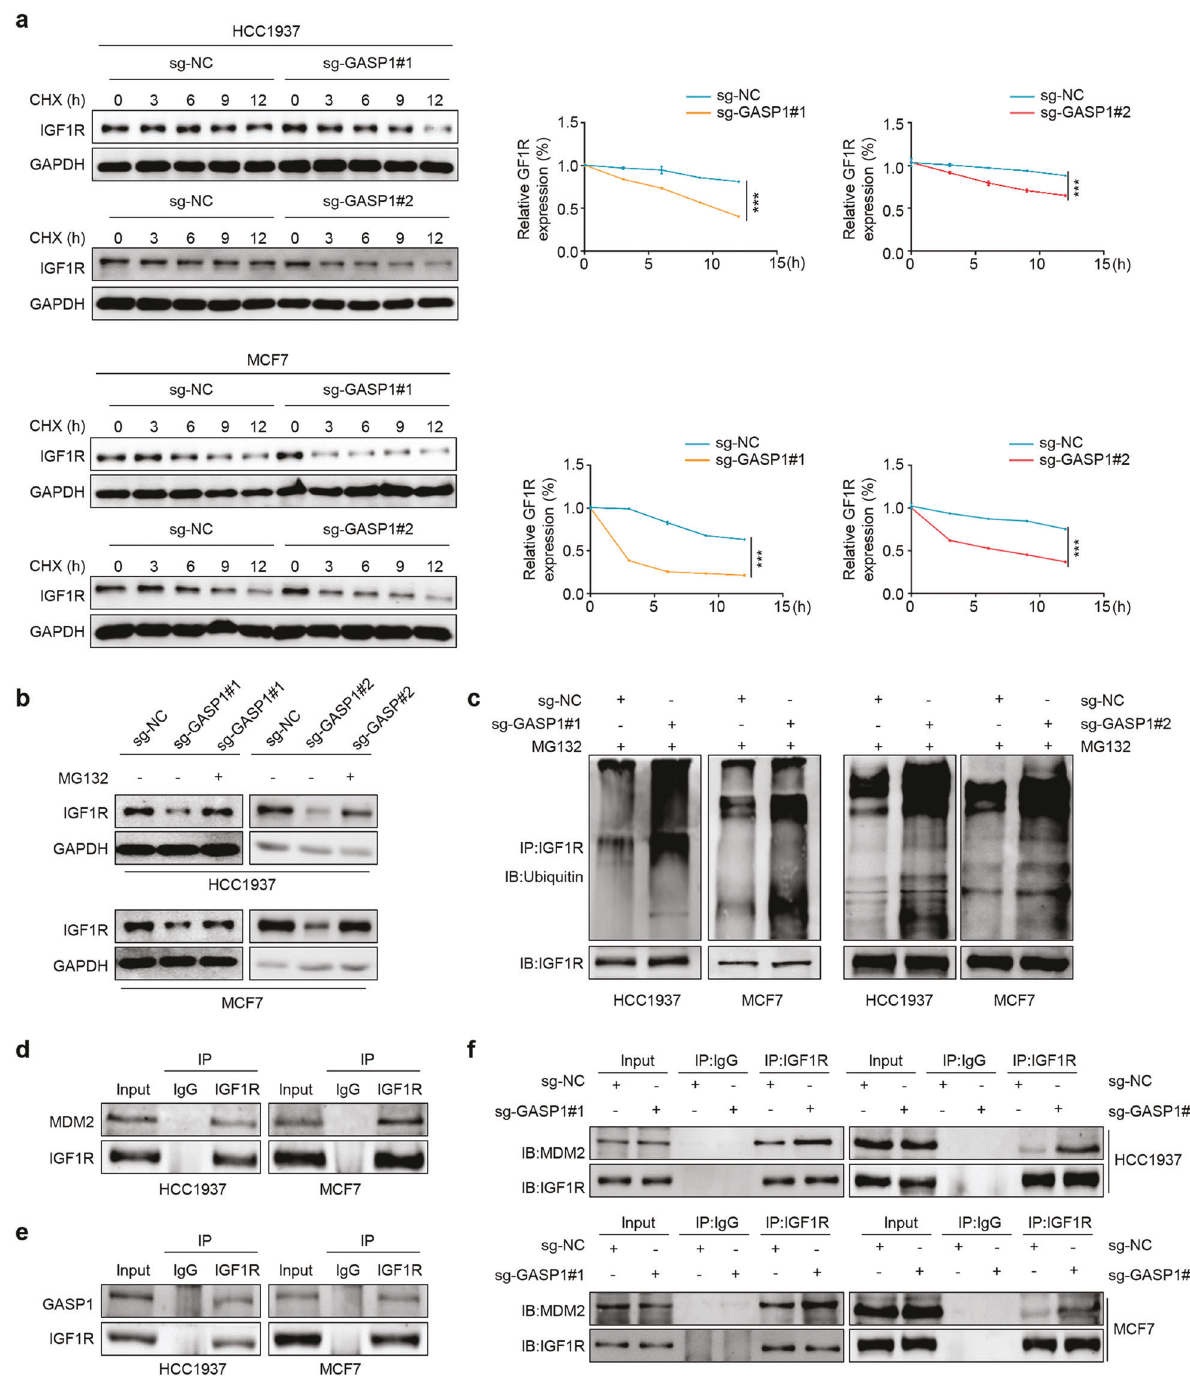
Fig. 5 GASP1 interacts with and stabilizes IGF1R. a GASP1 knockout HCC1937 and MCF7 cells and control cells were treated with CHX for the indicated times. Western blot analysis was then performed to analyze the expression of IGF1R proteins (left panels). GAPDH was used as a loading control. The quanti fi cation of IGF1R proteins in the above cells was shown in the right panels. Data are presented as mean ± SD. b GASP1 knockout cells were treated with 20 μ M MG132 for 8 h, and western blot analysis was then used to evaluate IGF1R expression. GAPDH was used as a loading control. c GASP1 knockout HCC1937 and MCF7 cells and control cells were treated with MG132 before harvesting. IGF1R ubiquitination was detected using immunoblot assay. d The interaction between MDM2 and IGF1R was detected by Co-IP assay in endogenous settings. IgG was used as a negative control. e The interaction between GASP1 and IGF1R was similarly detected by Co-IP assay. f The interaction between IGF1R and MDM2 was immunoprecipitated upon GASP1 knockout, and the expression of the indicated proteins was evaluated by immunoblotting using corresponding antibodies. *** P < 0.001.